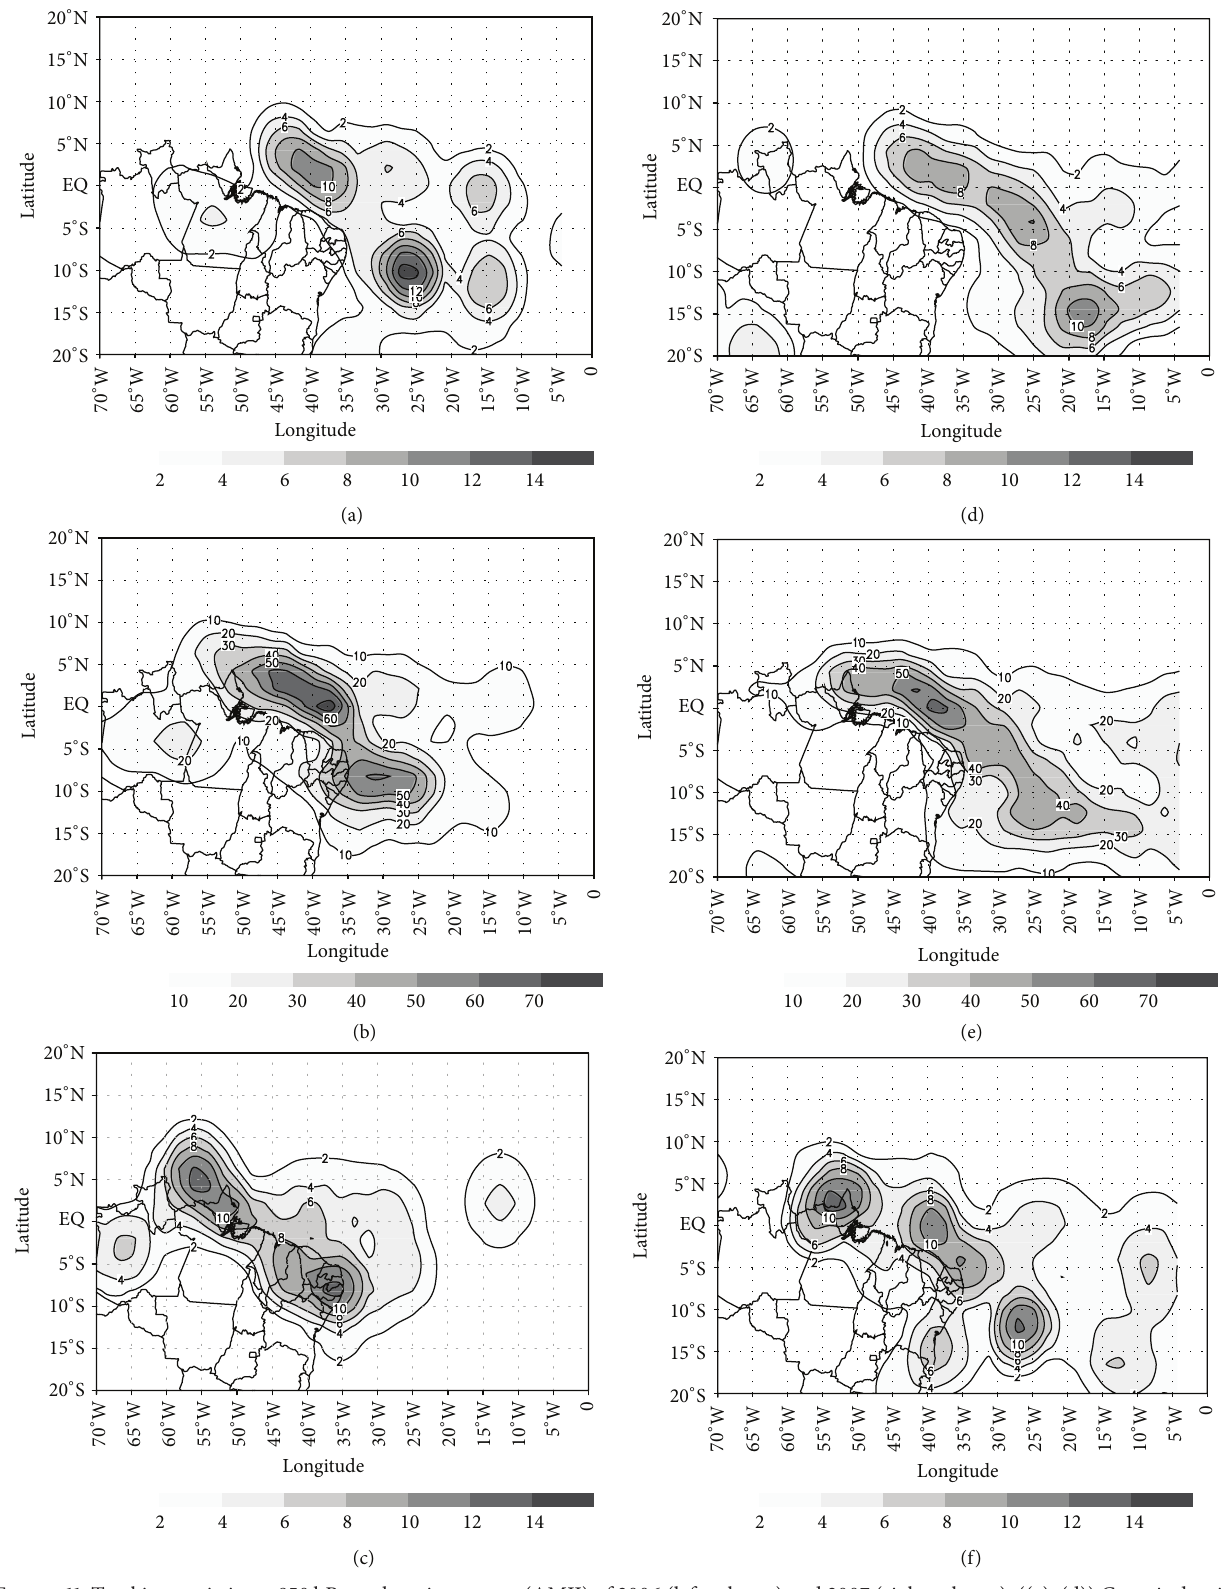
Figure 11: Tracking statistics at 850 hPa to the rainy season (AMJJ) of 2006 (left column) and 2007 (right column). ((a), (d)) Genesis density scaled to number density per unit area ( ∼ 10 6 km 2 ) per season, shading indicates values greater than 6. ((b), (e)) Track density per unit area ( ∼ 10 6 km 2 ) per season, shading indicates values greater than 40. ((c), (f)) Lysis density per unit area ( ∼ 10 6 km 2 ) per season, shading values are the same as in ((a),